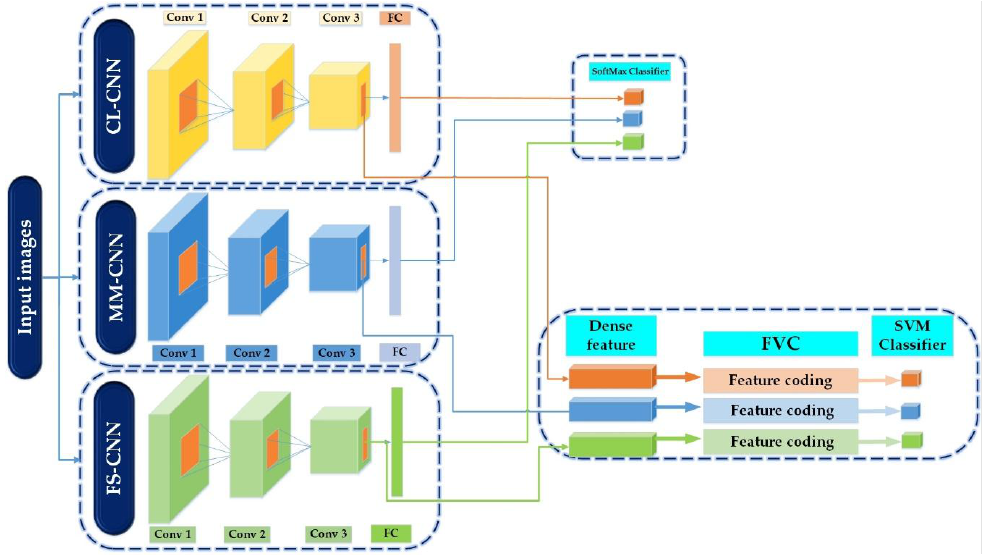
Figure 2. The framework of the proposed method.